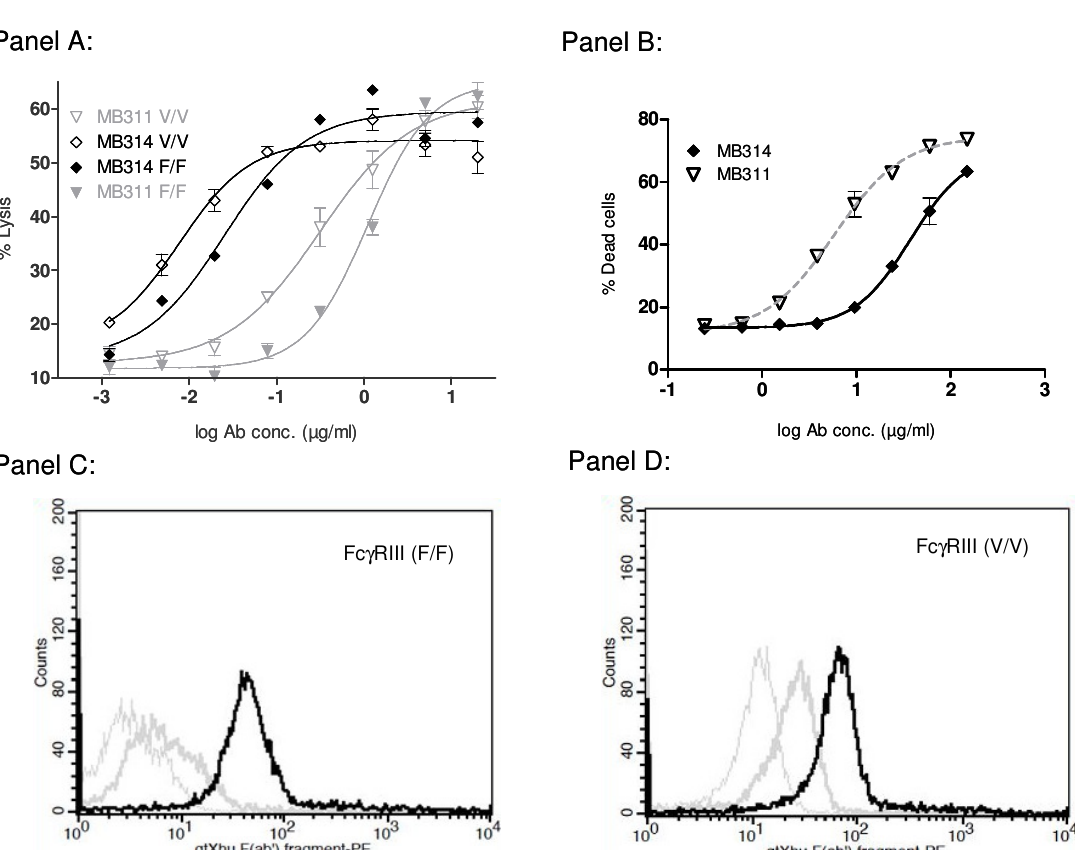
Figure 1. ADCC, CDC and NK cell binding by MB311 compared to its glyco-engineered variant MB314.